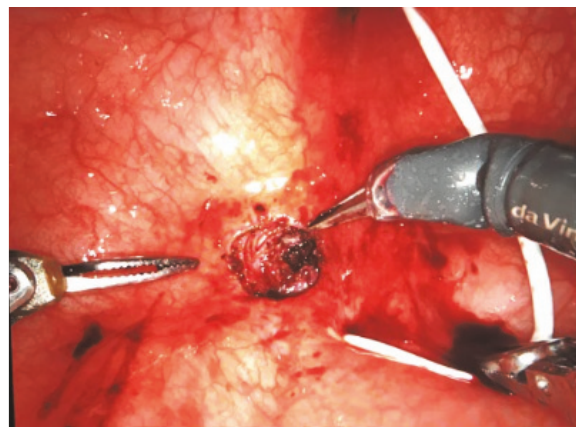
Figure 6: Final appearance of the treated fistula after suture of